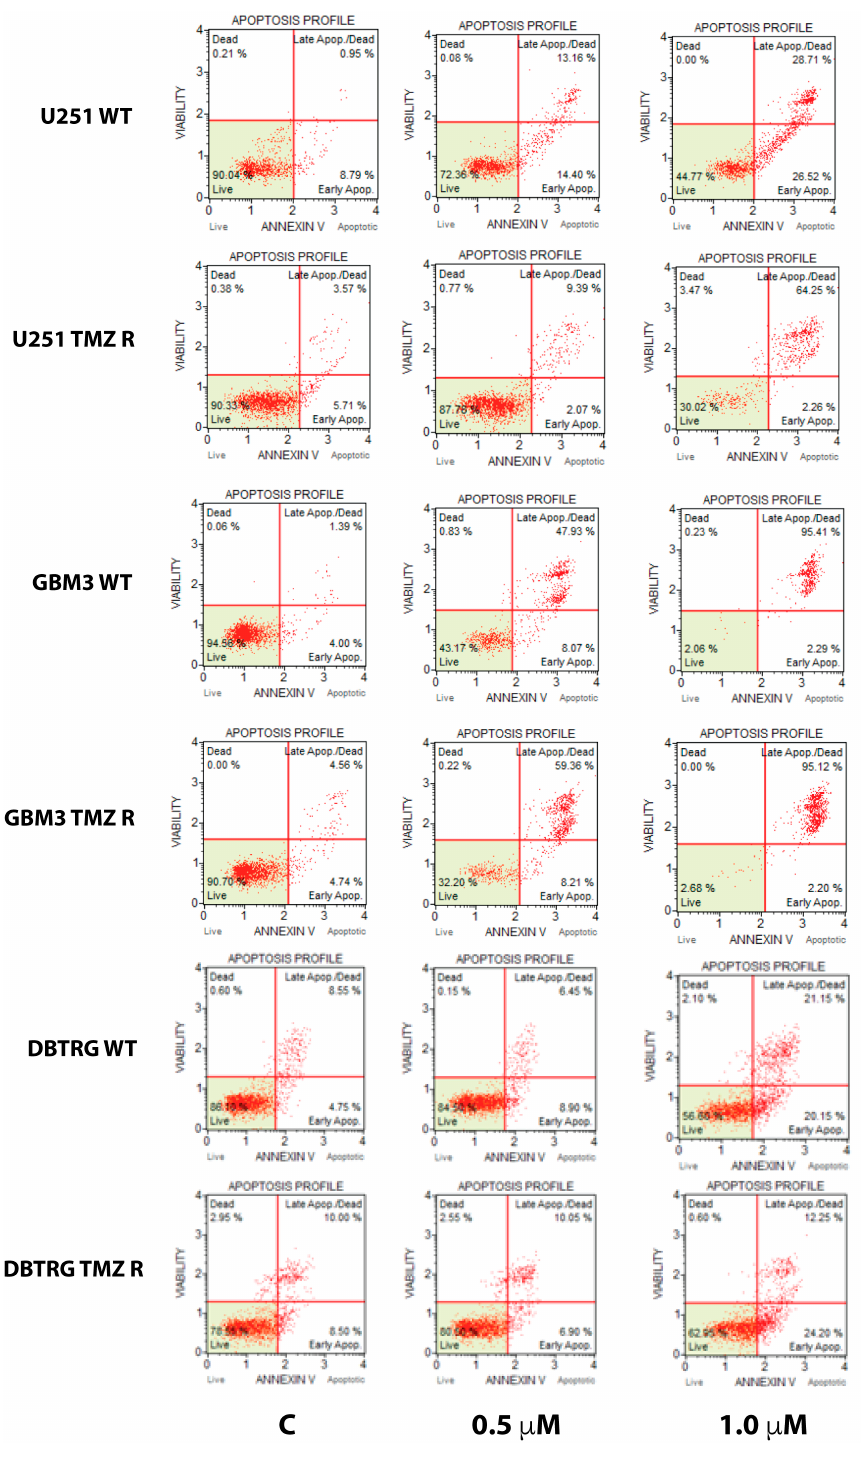
Figure 3. Induction of apoptosis by GSK J4 in native and TMZ-resistant glioblastoma (GB) cells. Representative scatter plots of annexin V staining at two molecule concentrations (0.5 and 1.0 µ M) and untreated control